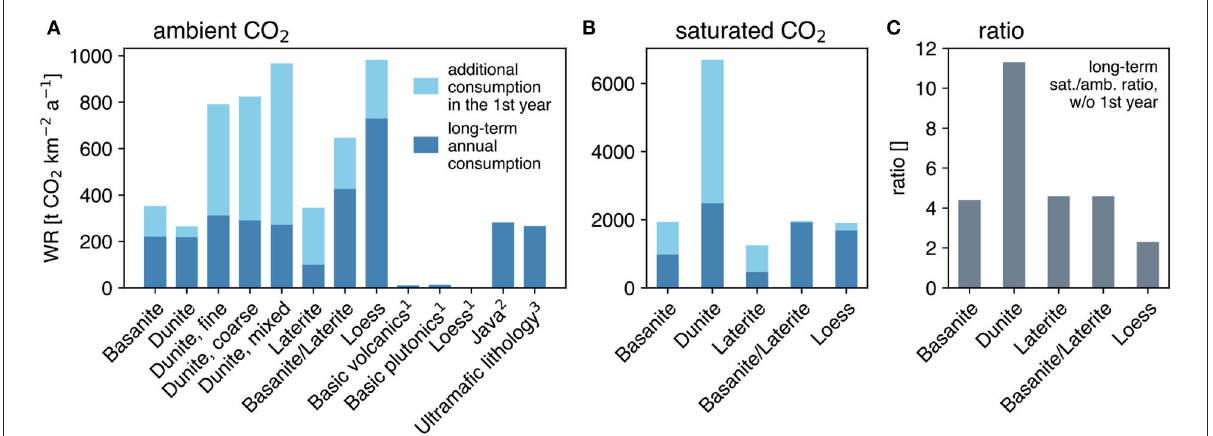
FIGURE6 The long-term annual CO 2 consumption normalized to land surface area in t CO 2 km − 2 a − 1 under ambient-CO 2 (A) and saturated-CO 2 conditions (B) . The light blue bars indicate the additional CO 2 consumption during the first year, as rates steeply increase during the first weeks of deployment. (C) The ratio between rates of saturated over ambient CO 2 conditions is based on the expected annual consumption without the initial flushing phase. 1 from Table 1 in Hartmann et al. (2009): 11.77, 13.97, and 2.05t CO 2 km − 2 a − 1 , respectively; 2 from Table 1 in Dessert et al. (2003); 3 from Table 6 in Schopka et al.